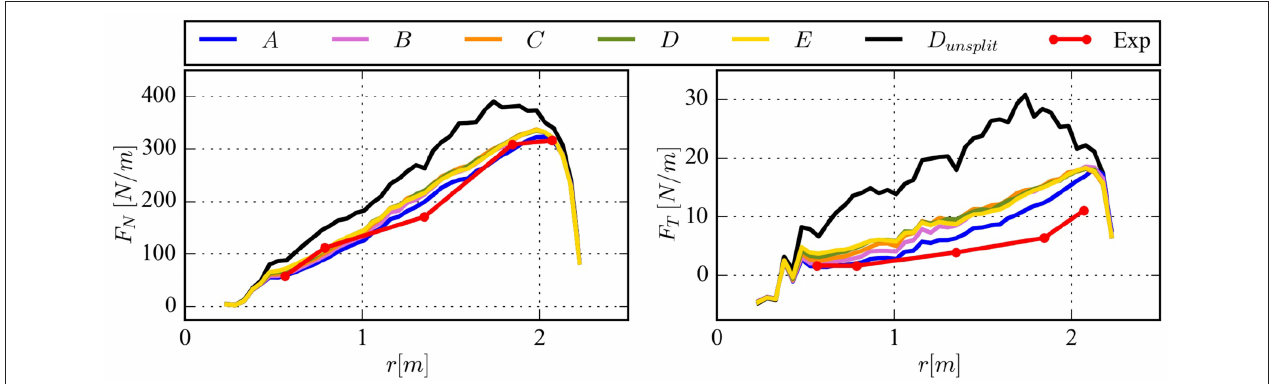
FIGURE 4 | Comparison of predicted normal F N and tangential F T forces per unit length along the blades for the 10 m/s case with the New MEXICO experiment (Boorsma and Schepers, 2014) for different time-splitting